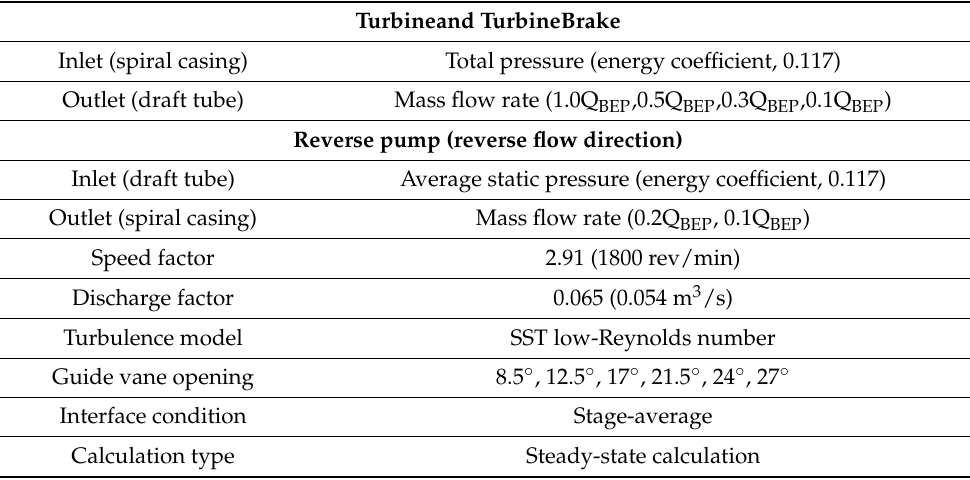
Table 3. Boundary conditions for predicting safety margin for S-shaped characteristics.